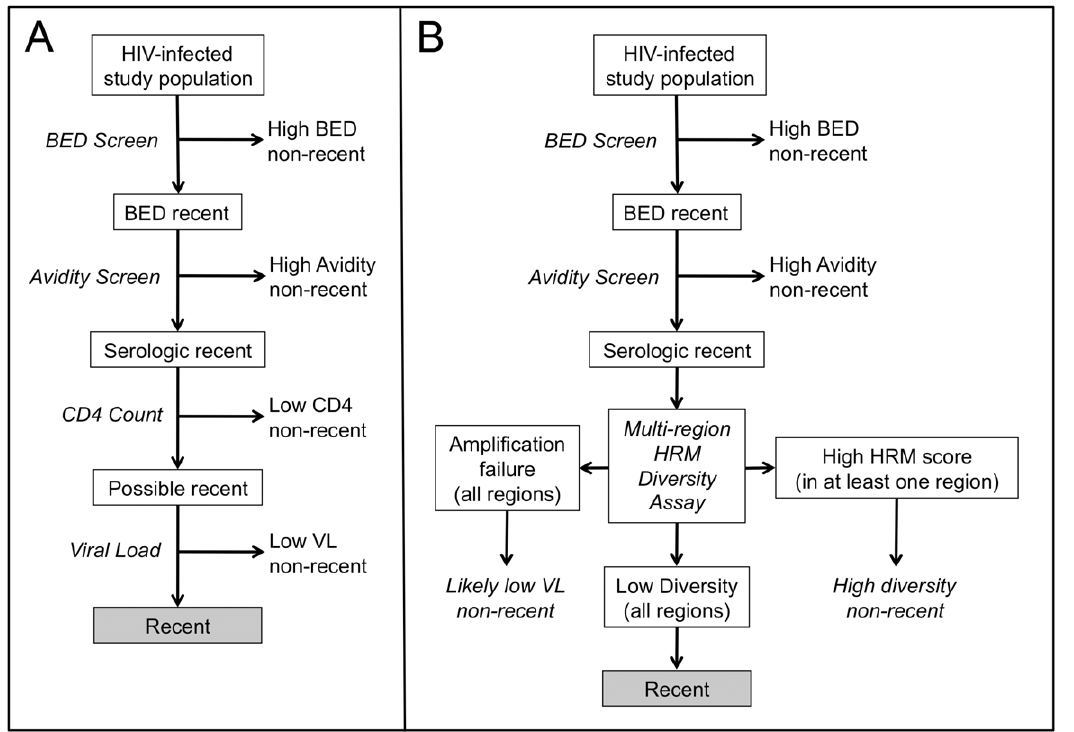
Figure 5. Use of the HRM diversity assay as part of a multi-assay algorithm for HIV incidence determination. Panel A shows one example of a multi-assay algorithm developed for HIV incidence determination. In this algorithm, samples from HIV-infected individuals are first tested using the BED-CEIA assay, using a high assay cutoff to indicate non-recent HIV infection (BED screen). Samples that are below the BED screen cutoff (BED recent samples) are then tested using a second serologic assay, such as one based on antibody avidity (avidity screen). Samples that are below the cutoff for the second serologic assay are considered to be ‘‘serologic recent’’ samples. Samples with low CD4 cell count test results are then excluded as non-recent (note that CD4 cell count test results are usually obtained for all HIV-infected individuals at the time of sample collection). Finally, samples that are not excluded based on CD4 cell count are tested using a viral load assay, and samples with low viral loads are excluded as non-recent. The remaining samples are characterized as recent for the purpose of estimating HIV incidence. Panel B shows an alternative multi-assay algorithm that incorporates the HRM diversity assay. In this algorithm, samples that are characterized as serologic recent based on two assays (BED screen and an avidity screen) are tested with a multi-region HRM diversity assay. Samples that have a high HRM score in at least one of the regions tested are excluded as non-recent. Samples that fail to amplify in all regions tested are also excluded as non-recent, based on the assumption that they have low viral loads; this could be confirmed with a viral load assay. Samples that have low HRM scores in all regions tested are characterized as recent for the purpose of estimating HIV incidence. assays for HIV incidence determination: a BED screening assay